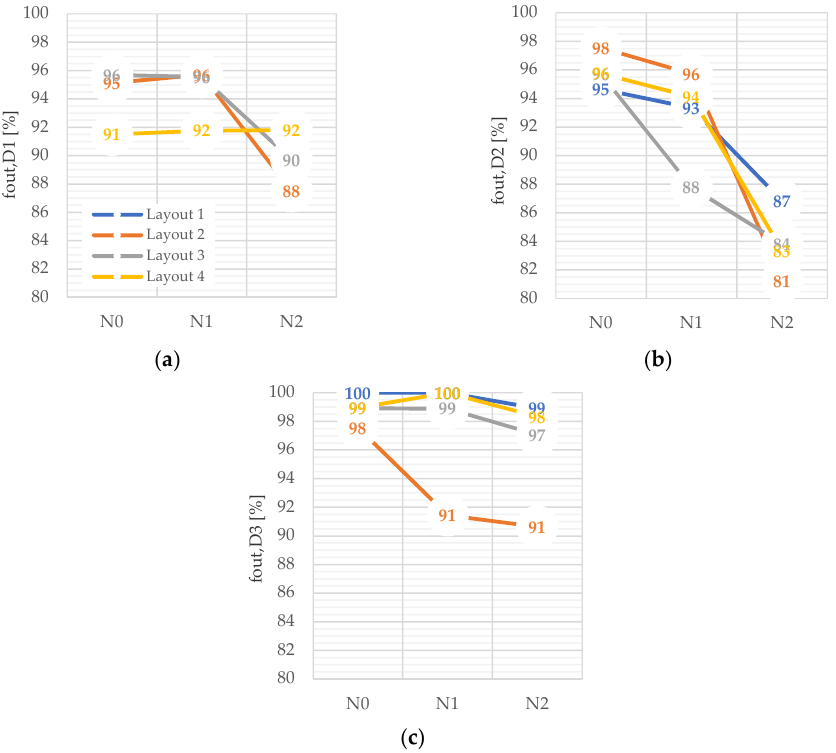
Figure 11. Relative frequency of outliers: ( a ) for damage D1; ( b ) for damage D2; ( c ) for damage D3.